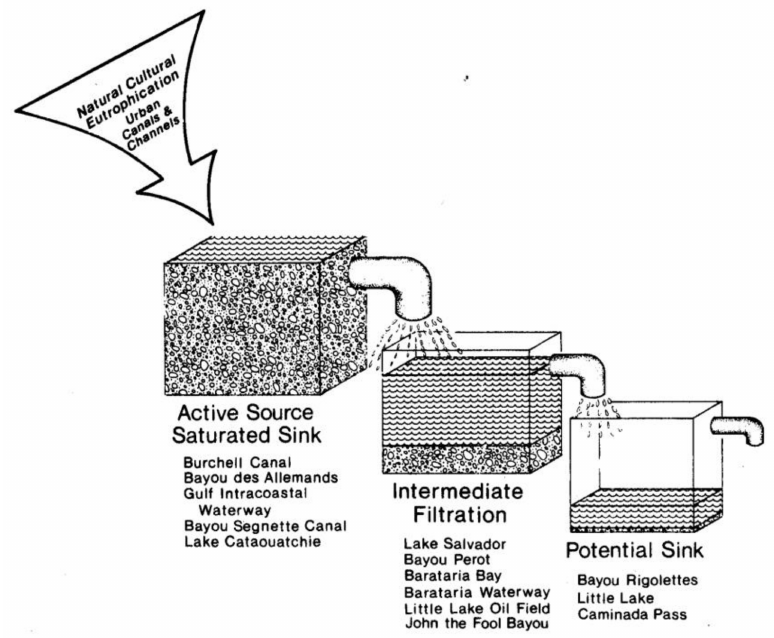
Figure 12. Conceptual model of nutrient uptake dynamics and trophic status of water bodies in the Barataria Basin (From [46]).